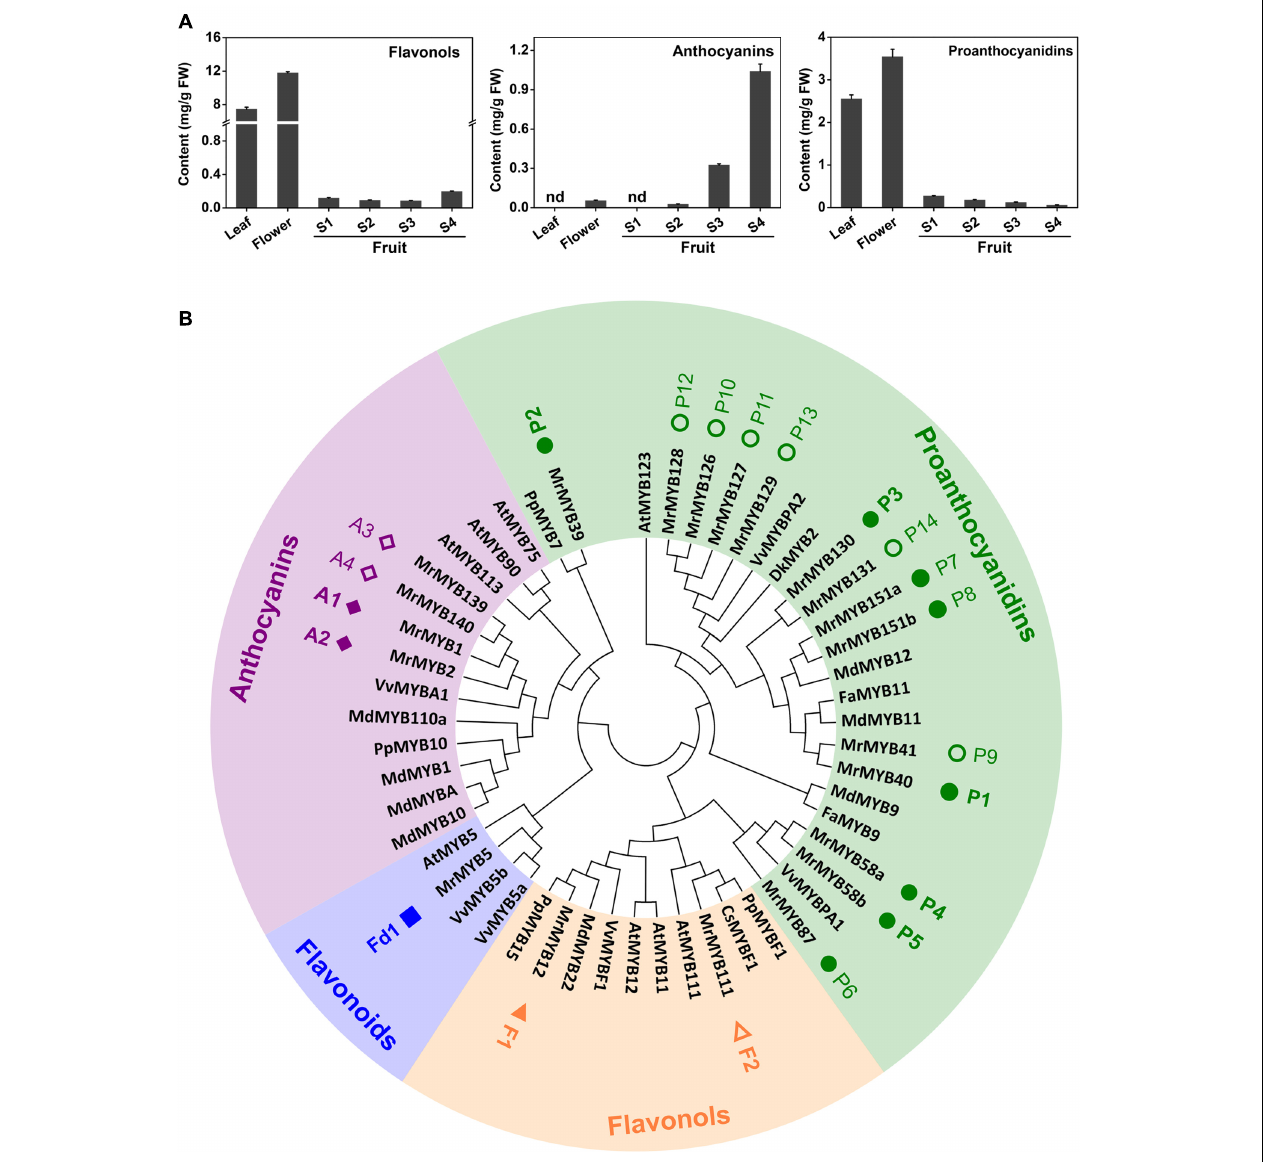
FIGURE 5 | Analysis of Chinese bayberry flavonoid contents (A) and phylogeny of MYBs in the anthocyanins, proanthocyanidins, flavonols, and flavonoids clades (B) . The square, triangles, rhombuses and circles represent MrMYBs of flavonoids, flavonols, anthocyanins, and proanthocyanidins clades, respectively. The solid symbols indicate the genes expressed in fruit, and the open symbols indicates the genes whose transcripts were not be detected in fruit. Error bars indicate S.E.s from three replicates. FW, fresh